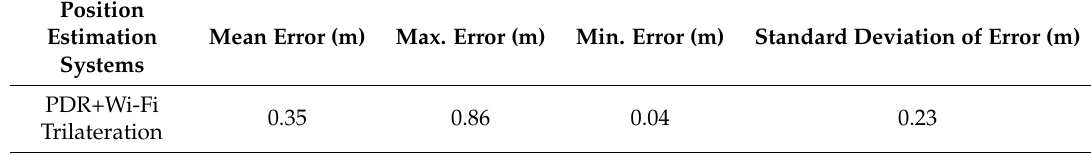
Table 3. Performance of different sensor fusion frameworks for path 2 straight-line